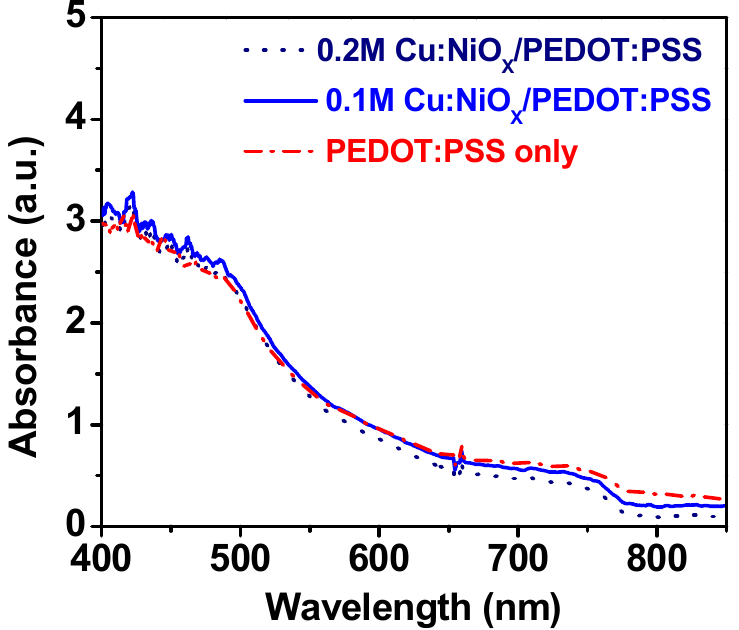
Figure 4. Absorbance spectra of perovskite on a PEDOT:PSS/Cu:NiO x /FTO/glass substrate and control device.